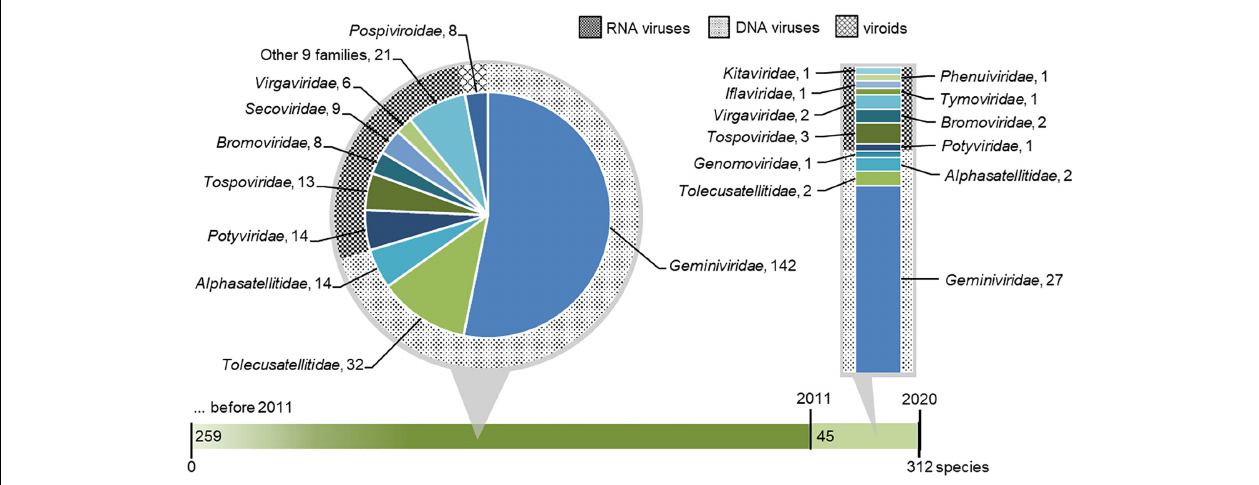
FIGURE 3 | Taxonomic distribution of virus and viroid species that were reported to infect or were associated with tomato. The green horizontal bar represents tomato viruses discovered before 2011 and within the 2011–2020 period. Known species reported before 2011 (including all known viruses that were first associated in tomato within the 2011–2020 period) are shown in the dark green portion on the left and extended in pie chart callout, where their distribution across viral families is shown. Species newly discovered in 2011–2020 are shown in the light green portion of the bar and extended in bar chart callout, where their distribution across viral families is shown. In both callouts, families of DNA viruses, RNA viruses, and viroids are designated with differently hatched backgrounds.